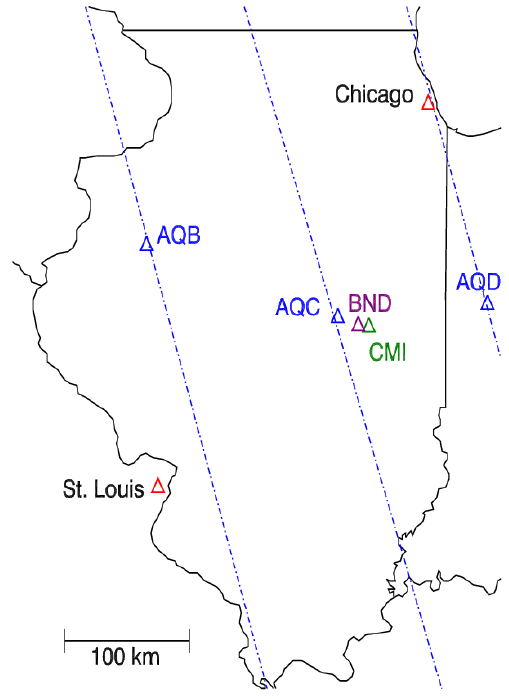
Fig. 3. Map of the study area showing the three AAO profile locations, the approximate A-Train satellite tracks, the BND surface monitoring site, and the AAO base of operations (CMI airport).